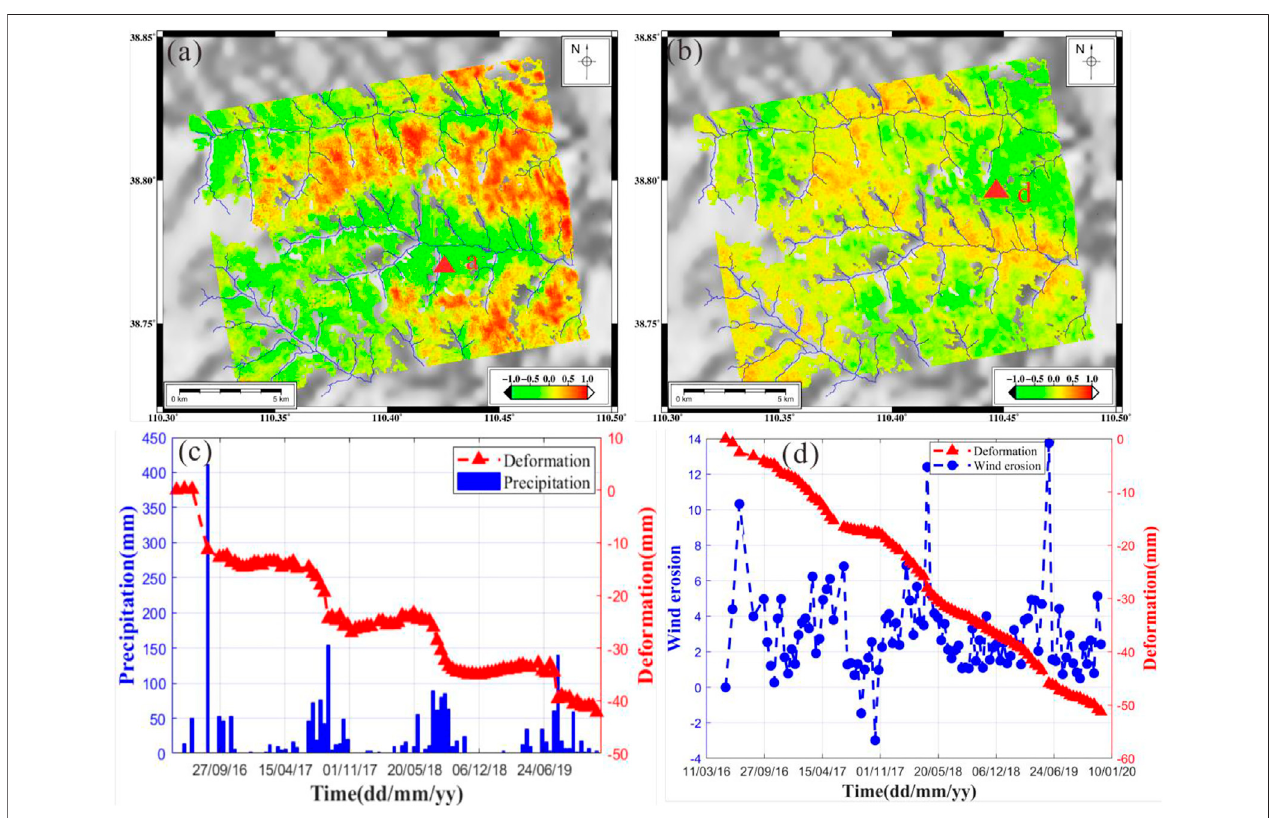
FIGURE8| Correlationbetweendeformationandexternalfactor. (A) Correlationcoef fi cientofsoilerosionandprecipitation, (B) correlationcoef fi cientofsoilerosion and wind erosion, (C) correlation analysis between soil erosion and precipitation at point a, (D) correlation analysis between soil erosion and wind erosion at point (D) .